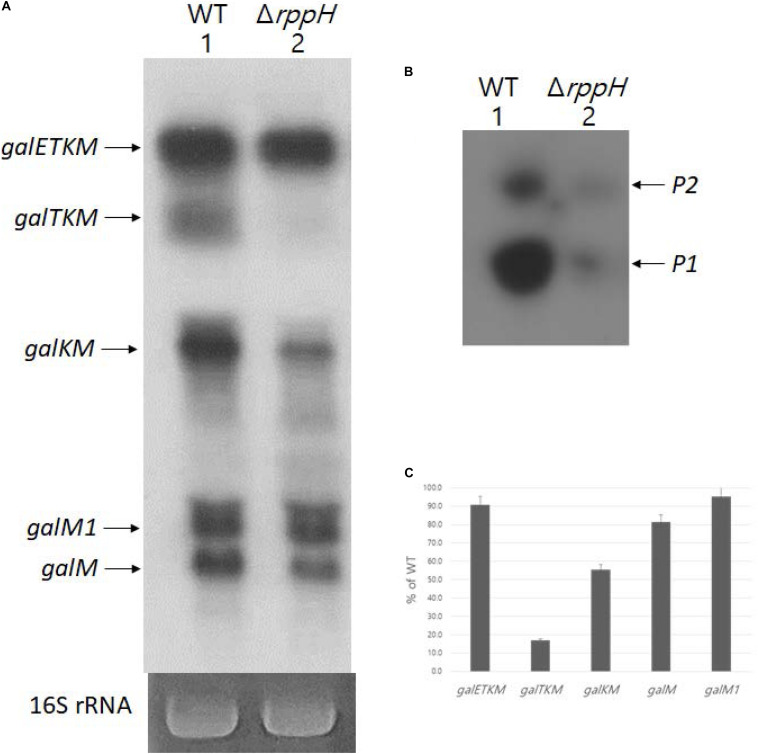
RNase E cleavage that results in galTKMgeneration requires 5’ mono-phosphate. (A) Northern blot (M-probed). (B) 5’RACE of galmRNA prepared from MG1655ΔrppHcells grown at OD600 of 0.6. (C) Quantification of each decay intermediate mRNA from (A) using the software ImageJ (NCBI, NIH).